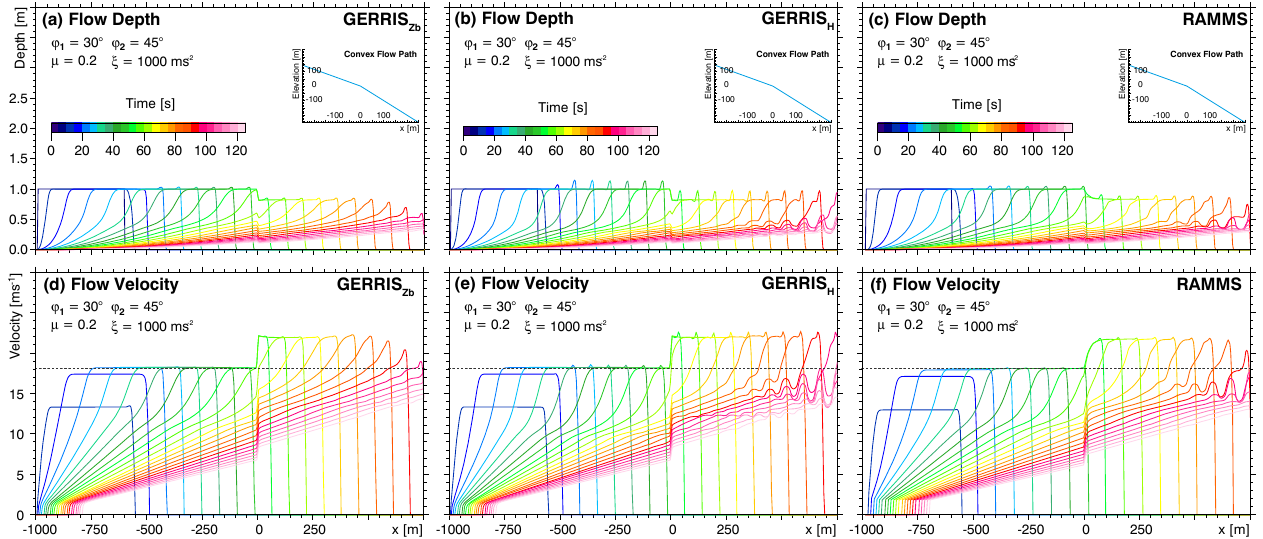
Figure 7. Time series of longitudinal profiles plotted for the scenario considered in Figs. 6 and 7 but with a sharp transition between the planar slope